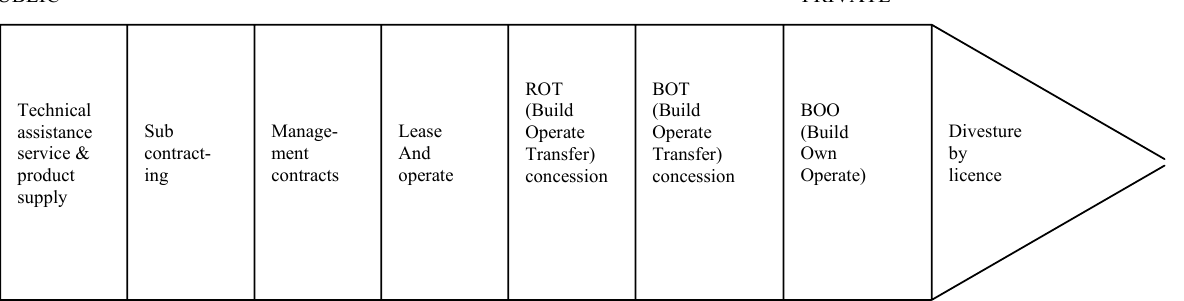
Figure 1: Modes of public-private partnerships A PPP comes in different forms - Fig 1. The various modes influence the RA process through the following three parameters – operational efficiency requirements, capital investment and asset ownership – by how these responsibilities are allocated between government and the private sector (Table